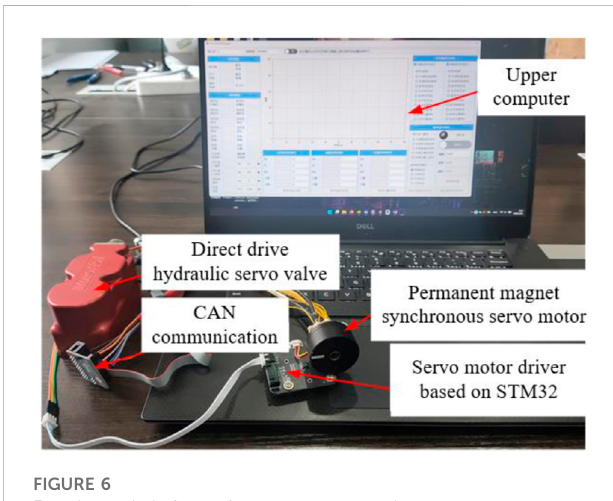
FIGURE 6 Experimental platform of servo motor control.